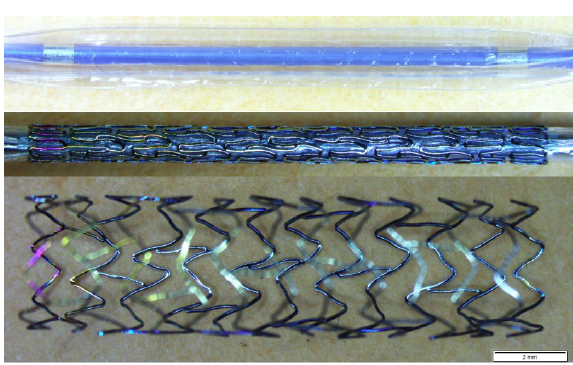
Figure 1. Balloon catheter, stent-system and